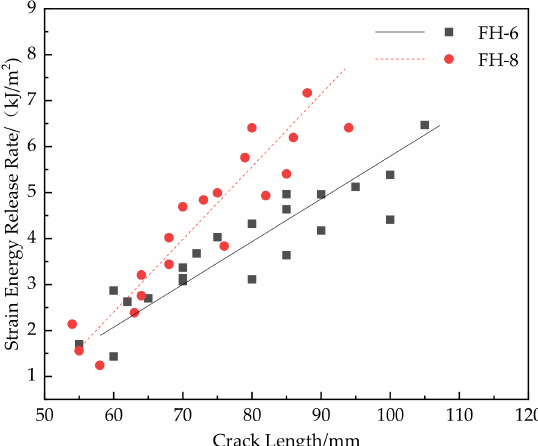
Figure 20. Comparison of release rate of the critical strain energy of FH-6 and FH-8 specimens with different crack